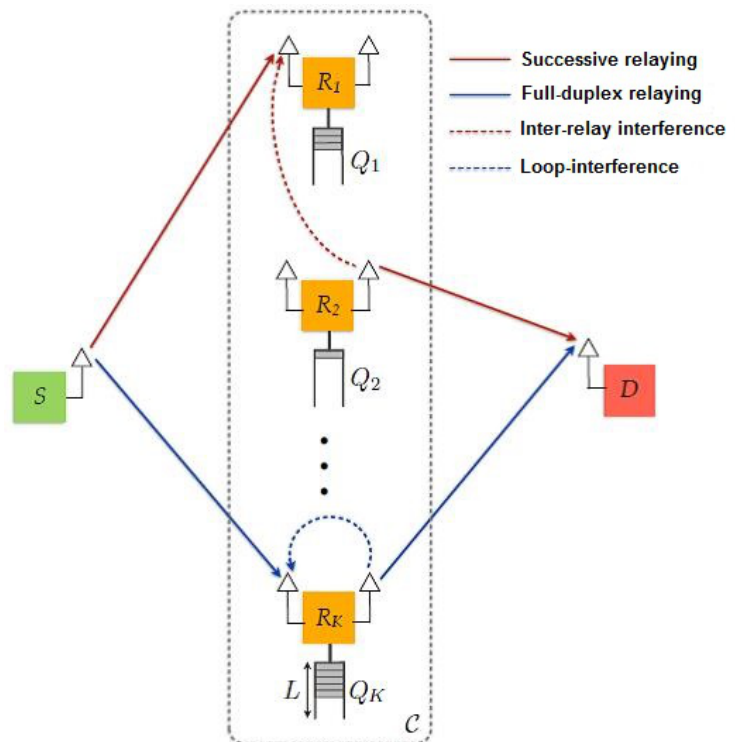
Figure 3. Over view of full-duplex